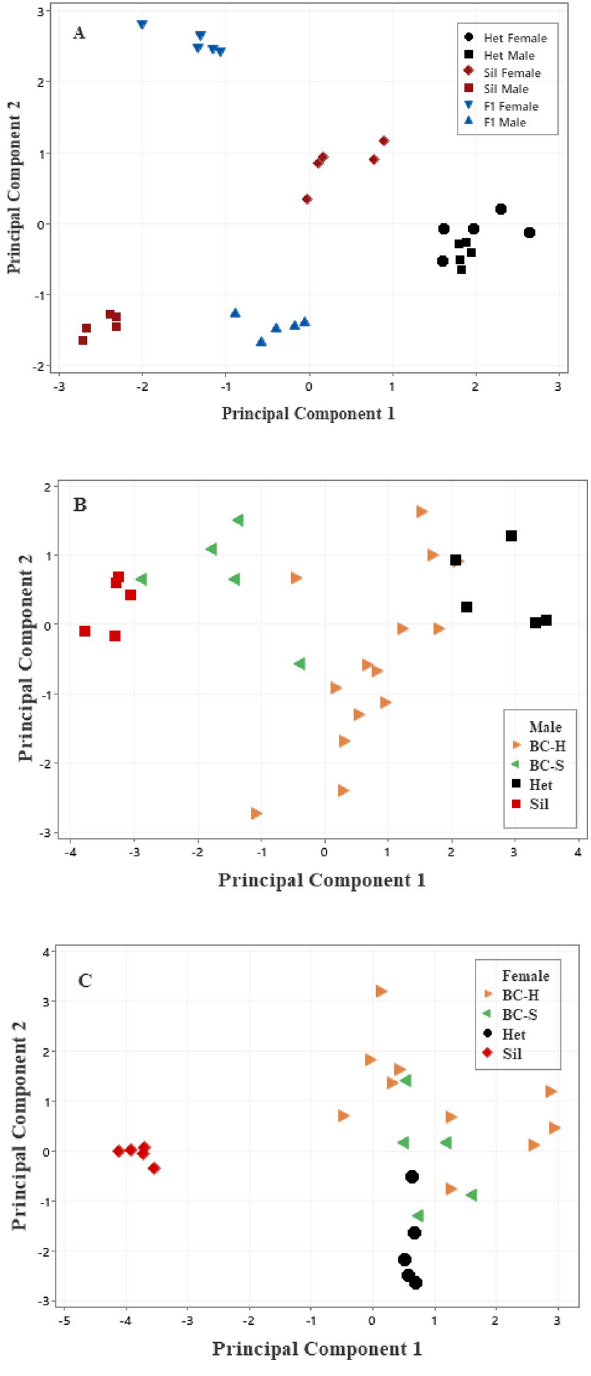
Figure 2. Scatterplot of principal component scores with ordinations representing differences in CHC compositions among genotypes for PC1 and PC2. ( A ) Parental and F1 hybrid females and males from the analysis of the six compounds found in F1 individuals. PC1 explained 47.2%, and PC2 explained 34.5% of the overall variation in the six CHCs (see Table S5). ( B ) Parental and backcross males from analysis of all nine compounds found in parental and backcross individuals. PC1 explained 51.6%, and PC2 explained 13.5% of the overall variation in the nine CHCs (see Table S9). ( C ) Parental and backcross females from analysis of all nine compounds found in parental and backcross individuals. PC1 explained 49.3%, and PC2 explained 21.6% of the overall variation in the nine CHCs (see Table S10. Symbols: D. heteroneura (Het), D. silvestris (Sil), F1